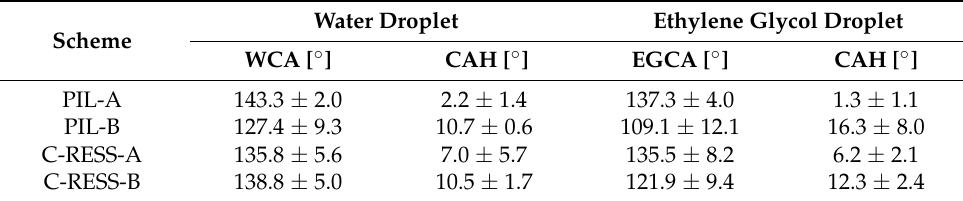
Table 4. WCA and EGCA and its contact angle hysteresis (CAH) of PIL and C-RESS micro-structure with resin A and resin B on PC foil after scratch